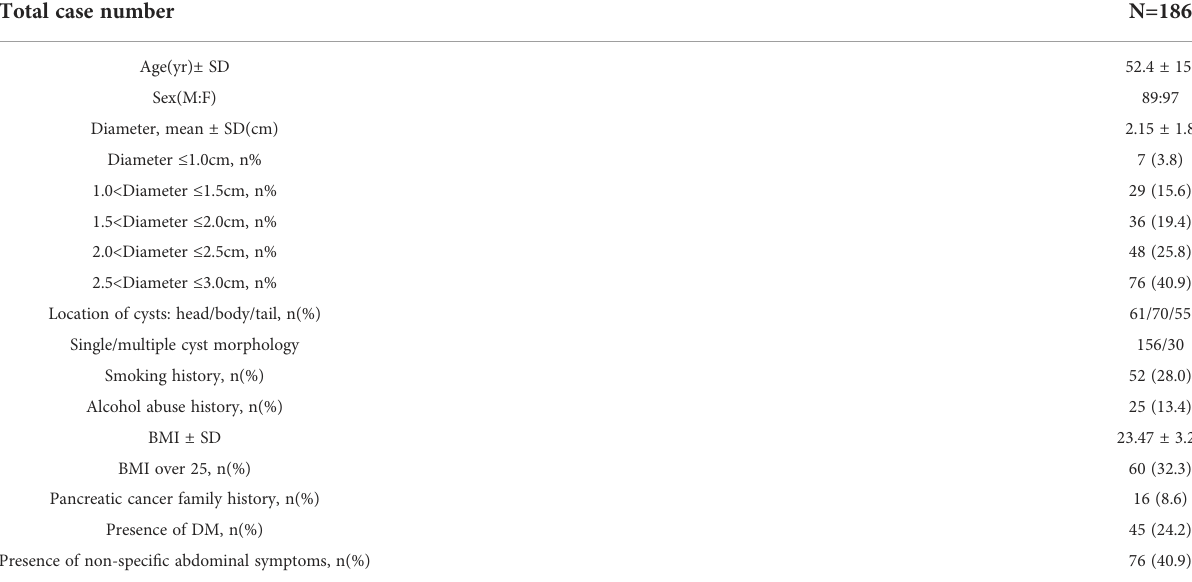
TABLE 1 Clinical and imaging characteristics of 186 pancreatic cystic neoplasm patients.